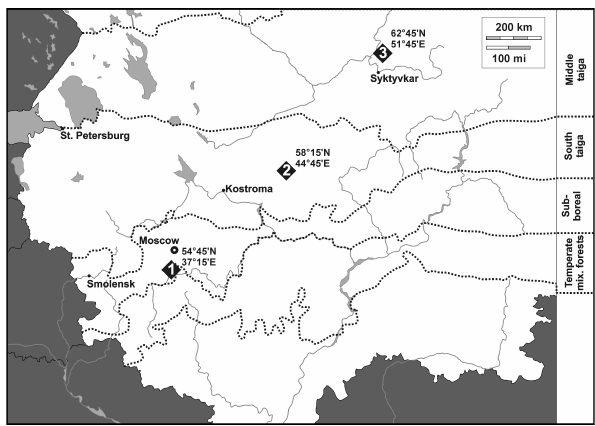
Fig. 2. Areas under study: 1 – Dankovskoe forest area; 2 – Man- turovskoe forest area; 3 – Zheleznodorozhnoe forest area. Dashed lines delineate approximate borders of vegetation subzones. Geo- graphic coordinates for the CRU TS 2.0 dataset grid box closest to the corresponding area under study are shown. Based on a map by Daniel Dalet (d-maps.com). From Shanin et al. (2012), as subse- quently amended.